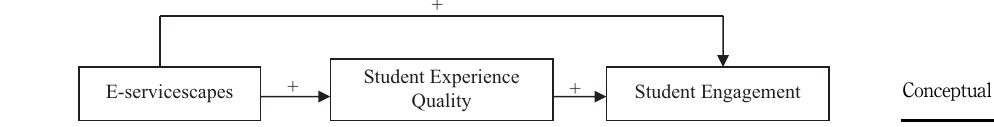
Figure 1. Conceptual